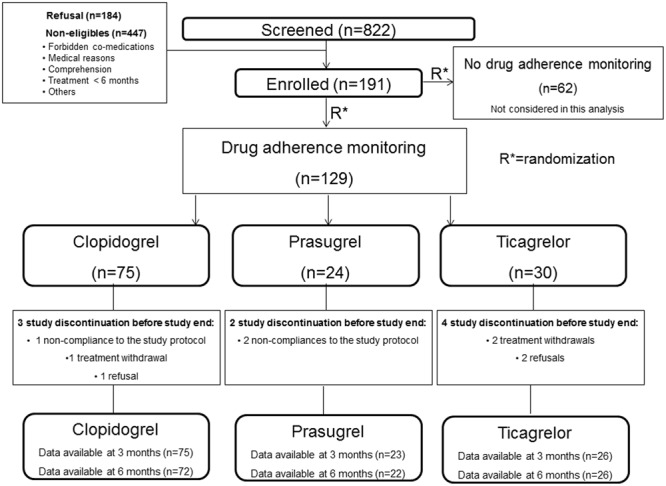
Flow diagram of the study.